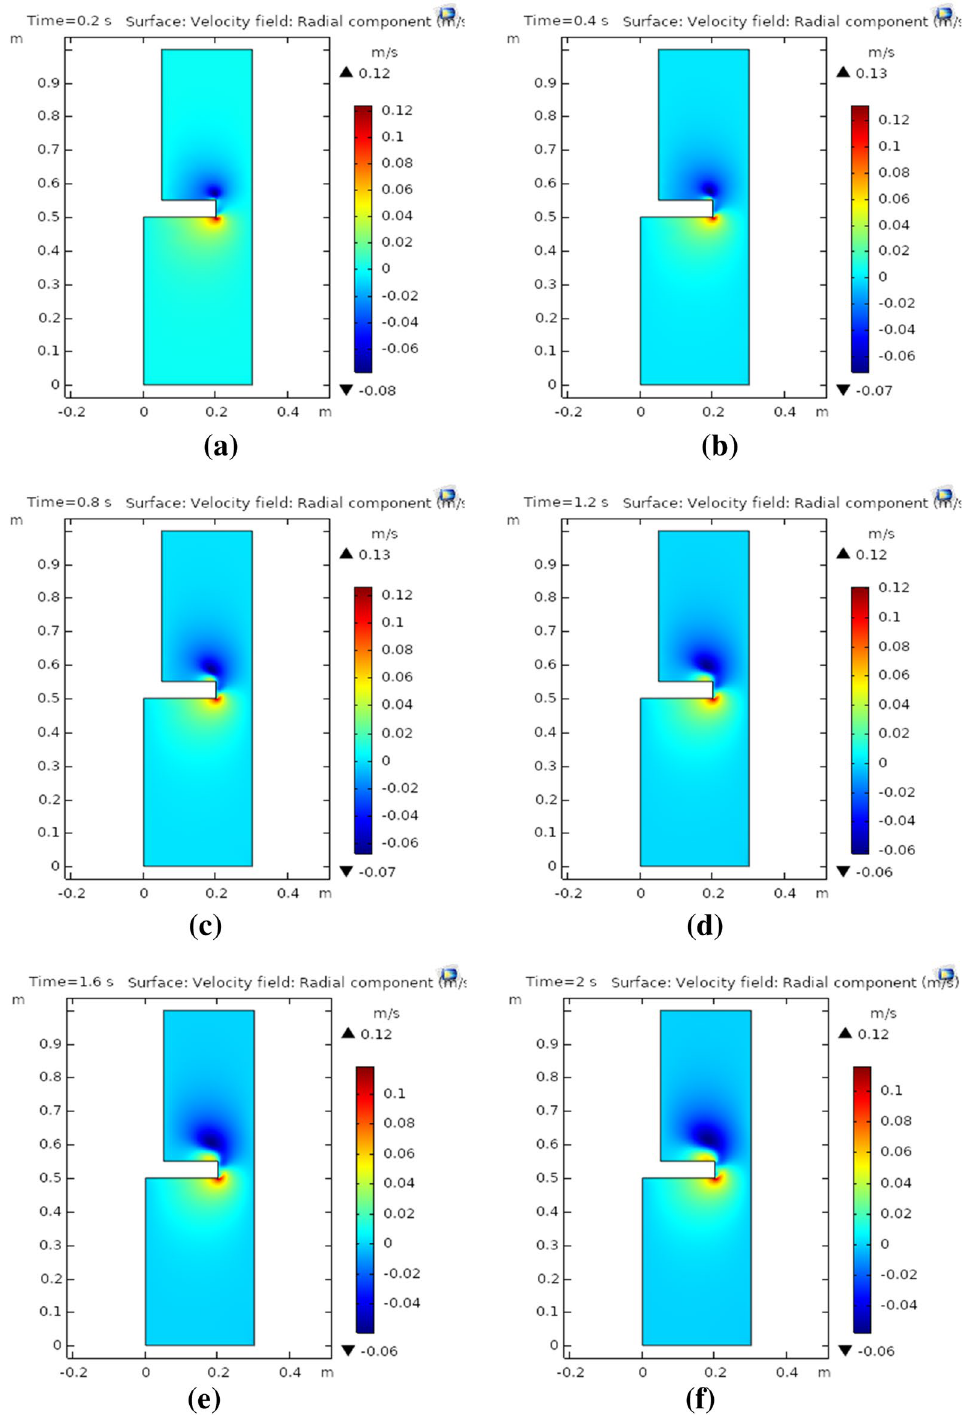
Figure 2. (a) Radial component at 0.2 s, (b) radial component at 0.4 s, (c) radial component at 0.8 s, (d) radial component at 1.2 s, (e) radial component at 1.6 s, (f) radial component at 2